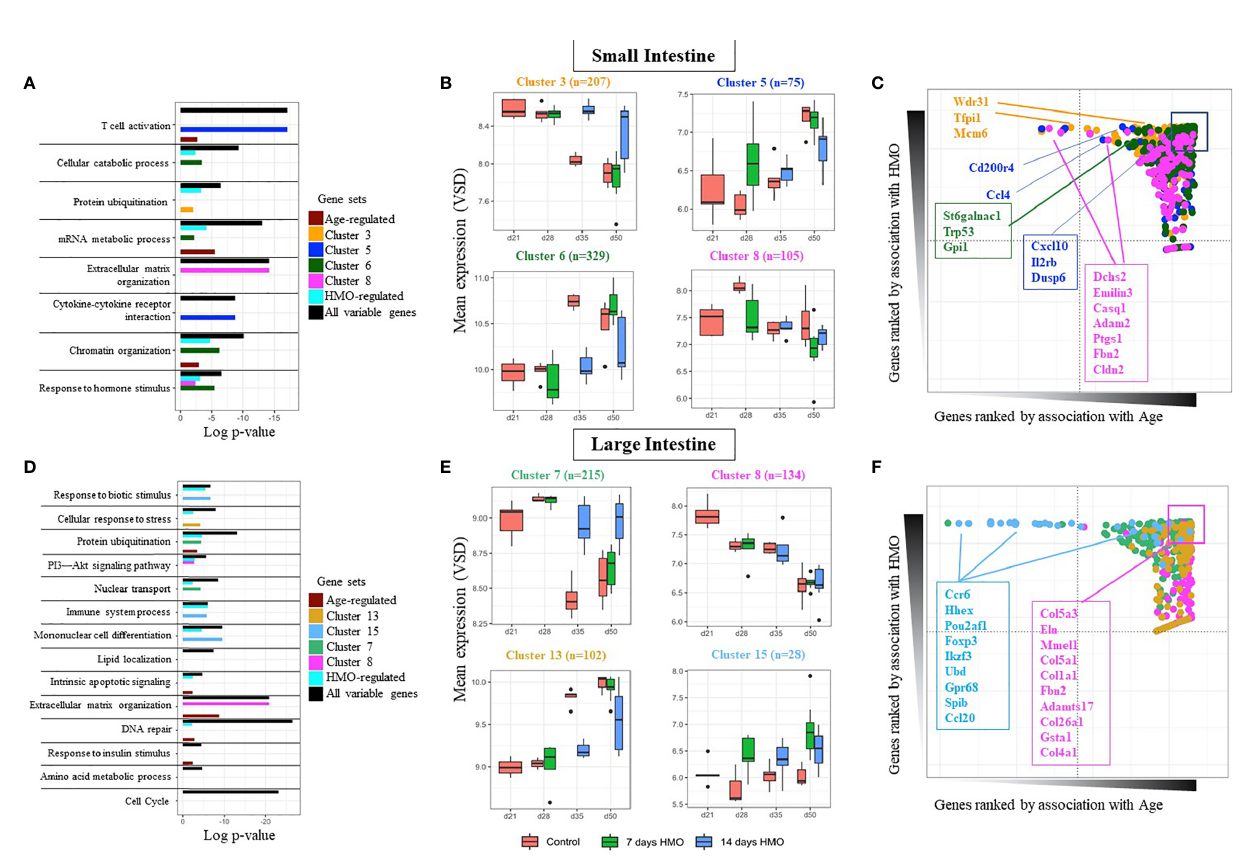
FIGURE 5 | Gene cluster – based analysis for SI samples (A) Pathway enrichment based for several gene classes: All variable genes (highly variable genes regardless of factor); Age (genes most affected by age), Condition (genes most affected by HMO feeding), and for speci fi c clusters of co-expressed genes (shown here for clusters 3, 5, 6, and 8). (B) Gene expression pro fi le of selected gene clusters in SI samples. Each bar represents data from at least 5 replicates. (C) Rank distribution plot of selected genes in each SI cluster in (B) highlighting individual contributions of age and HMO to the gene ’ s expression pro fi le. (D – F) same as above for large intestine samples (LI). GF mice weaned at 21 days of age (n=3 F); Groups (conditions): Control GF mice euthanized either at 28 days of age (n= 9; M=5, F=4) or 35 days of age (n= 5; M=3, F=2) or 50 days of age (n= 5; M=1, F=4) respectively; 7d HMOs euthanized at d28 = GF mice that received 100 ul of HMO through 7 consecutive days and euthanized at 28 days of age (n= 5; M=2, F=3); HMO_14d_D35 = GF mice that received 100 m l of HMO through 14 days and euthanized at 35 days of age (n= 6; M=3, F=3); HMO_7d_D50 = GF mice that received 100 m l of HMO through 7 consecutive days and euthanized at 50 days of age (n= 5; M=1, F=4); HMO_14d_D50 = GF mice that received 100 m l of HMO through 14 consecutive days and euthanized at 50 days of age (n= 10; M=7,